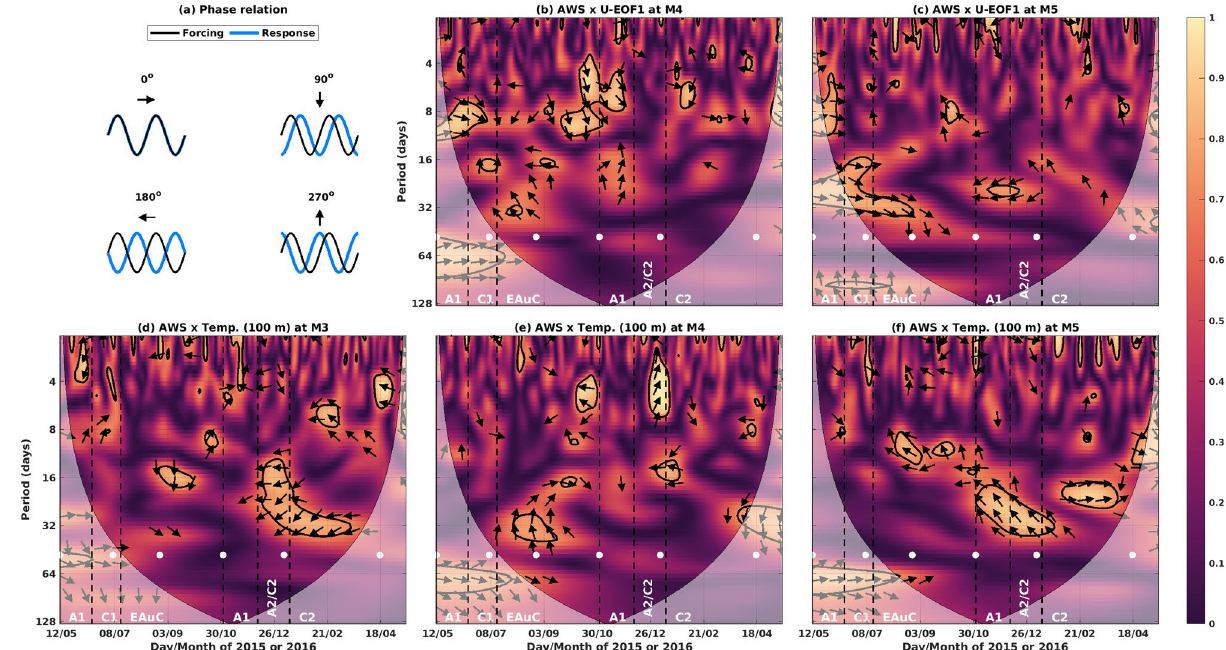
Figure 7. ( a ) Phase relations for wavelet coherency between forcing (black) and response (blue). ( b ) Squared wavelet coherency between AWS (forcing) and U-EOF1 (response) at M4. ( c ) Same as ( b ) but at M5. ( d ) Squared wavelet coherency between AWS and 100 m temperature at M3. ( e ) Same as ( d ) but at M4. ( f ) Same as ( d ) but at M5. The black contour lines indicate coherency above 0.95 at the significance level of p < 0.05 , and the arrows indicate the relative phase relationship explained in ( a ).